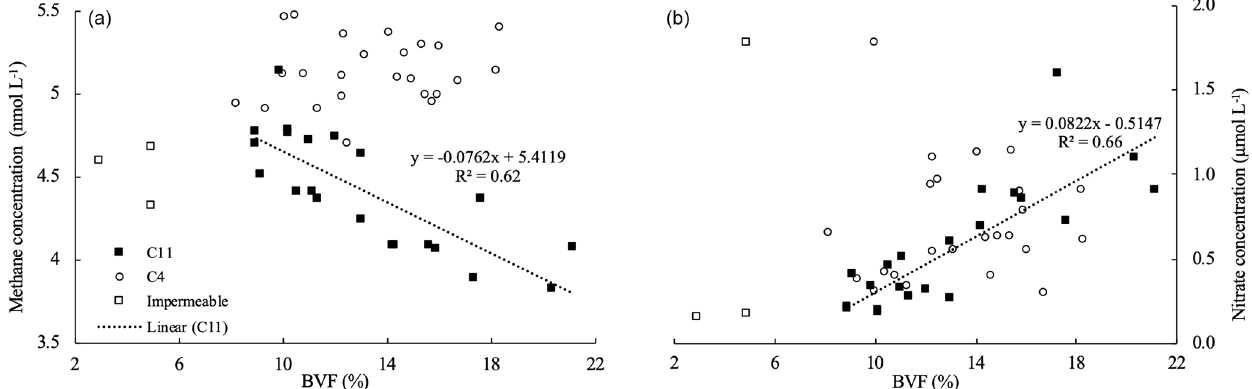
Figure 7. (a) Methane and (b) nitrate concentration vs. brine volume fraction (BVF) at C11 and C4, respectively. In C11, methane is inversely correlated ( R 2 = 0 . 62), while nitrate is correlated ( R 2 = 0 . 66) with increasing BVF. This trend shows that methane is released from ice, while nitrate is taken up. In station C4, correlation is missing when sea ice is fully permeable. C4 shows a homogenously distribution of methane, as well as nitrate, and a higher concentration than in C11 caused by the flushing of seawater charged with methane and nitrate into the sea ice. The three outlier points (impermeable ice layers) have been removed for the